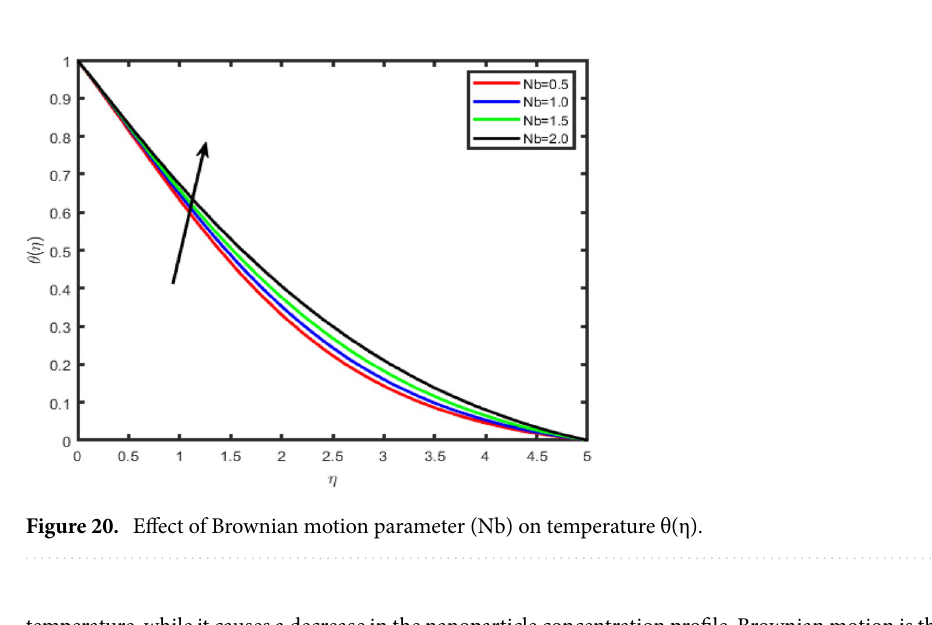
Figure 19. Effect of heat source parameter (Q) on concentration ϕ(η).